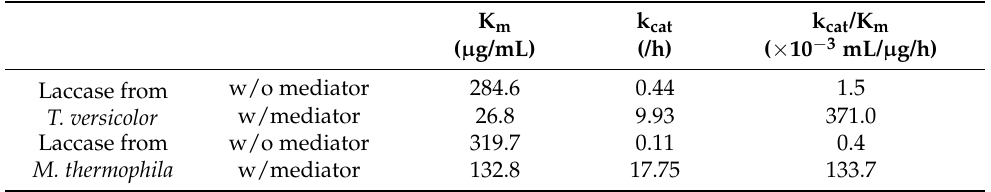
Table 1. Kinetic constants of laccase from T. versicolor and M. thermophila for the melanin decoloriza- tion reaction using acetosyringone as a mediator.